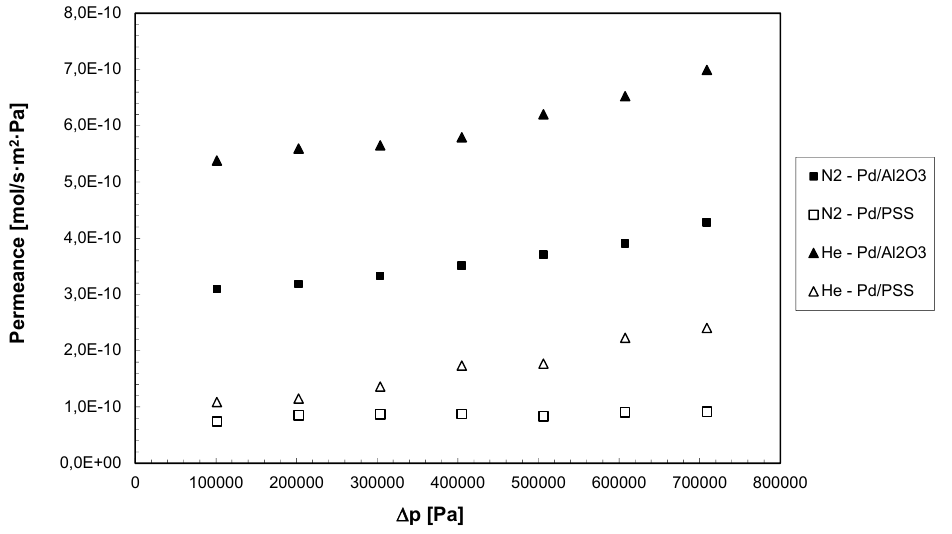
Figure 3. N and He permeances as a function of trans-membrane pressure for both 2 Pd-based membranes at T = 400 °C.